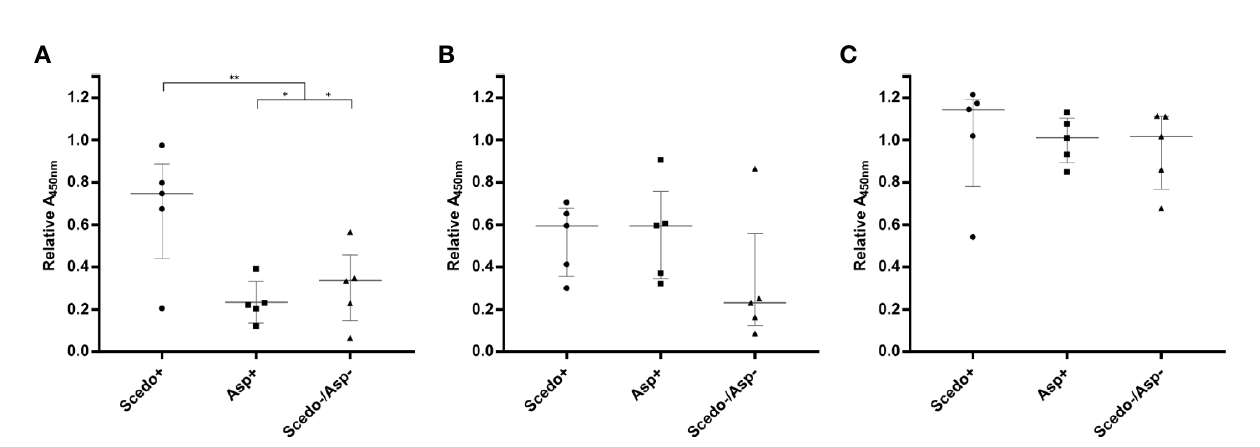
FIGURE 5 | Immunoreactivity of CF patients ’ serum IgGs to other fungal pathogens. Immunoreactivity of speci fi c serum IgG against Total CWP of L. proli fi cans (A) , A. fumigatus (B), and C. albicans (C) is represented as the relative Abs value at 450 nm obtained for each serum. Wide horizontal lines depict the median, and short horizontal lines represent the interquartile range (IQR), except for graph A where media (SD) is represented. Comparison of the median value among Scedo+ group and each of the other two groups, and for the sum of both as negative samples (** p < 0.01; * p <